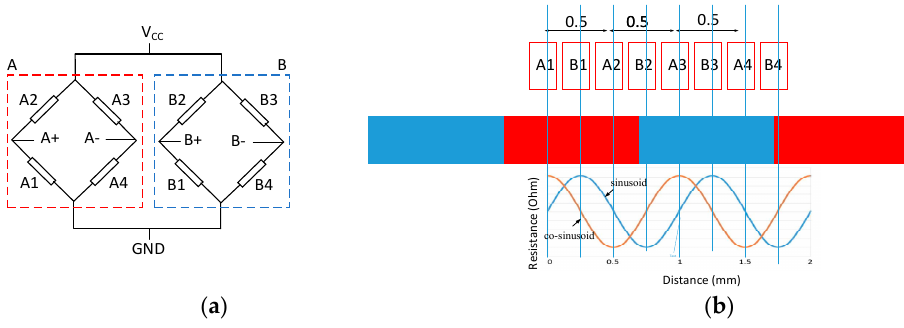
Figure 2. ( a ) Wheatstone bridge; ( b ) electrode layout and resulting harmonic resistance variation.